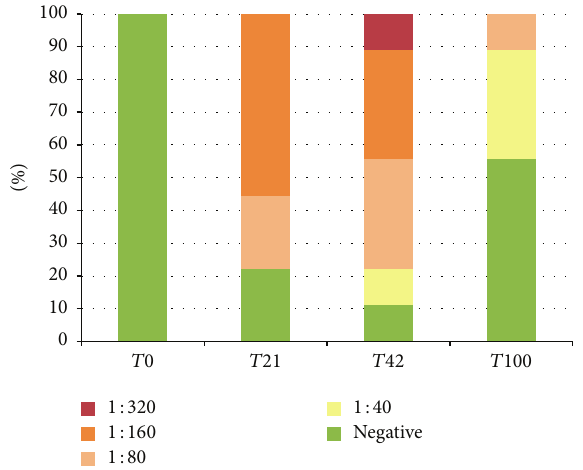
Figure 3: IFAT positivity (%), Group